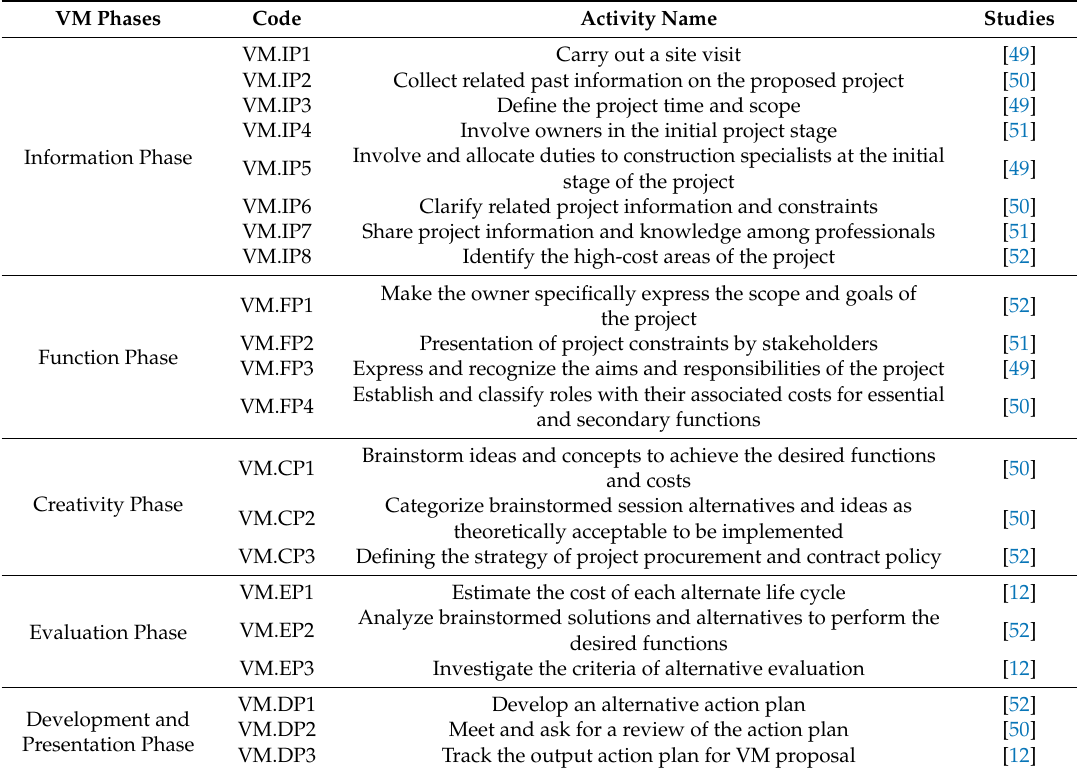
Table 1. VM activities in the construction